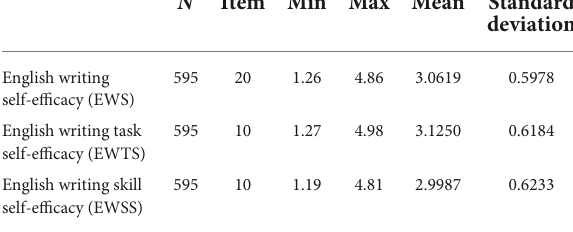
TABLE 1 Results of descriptive analysis of English writing self-efficacy.